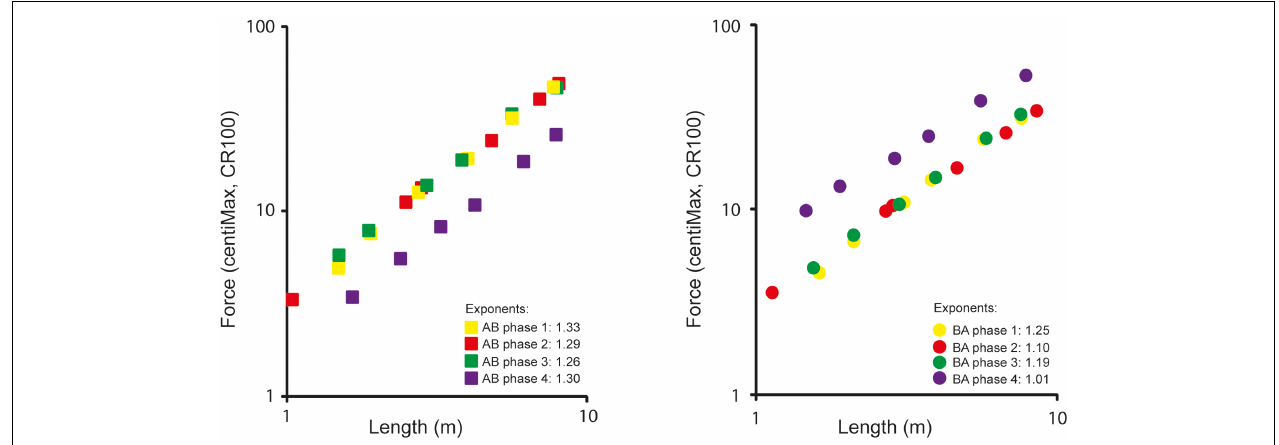
FIGURE 5 | Psychophysical relationships between CR100 intensity and putting length (log m) forAB and BA groups during phases 1 to 4. Note. In accordance with psychophysical customs, and in order to ease comparisons, the power functions in this figure are expressed as linear “log–log plots.”